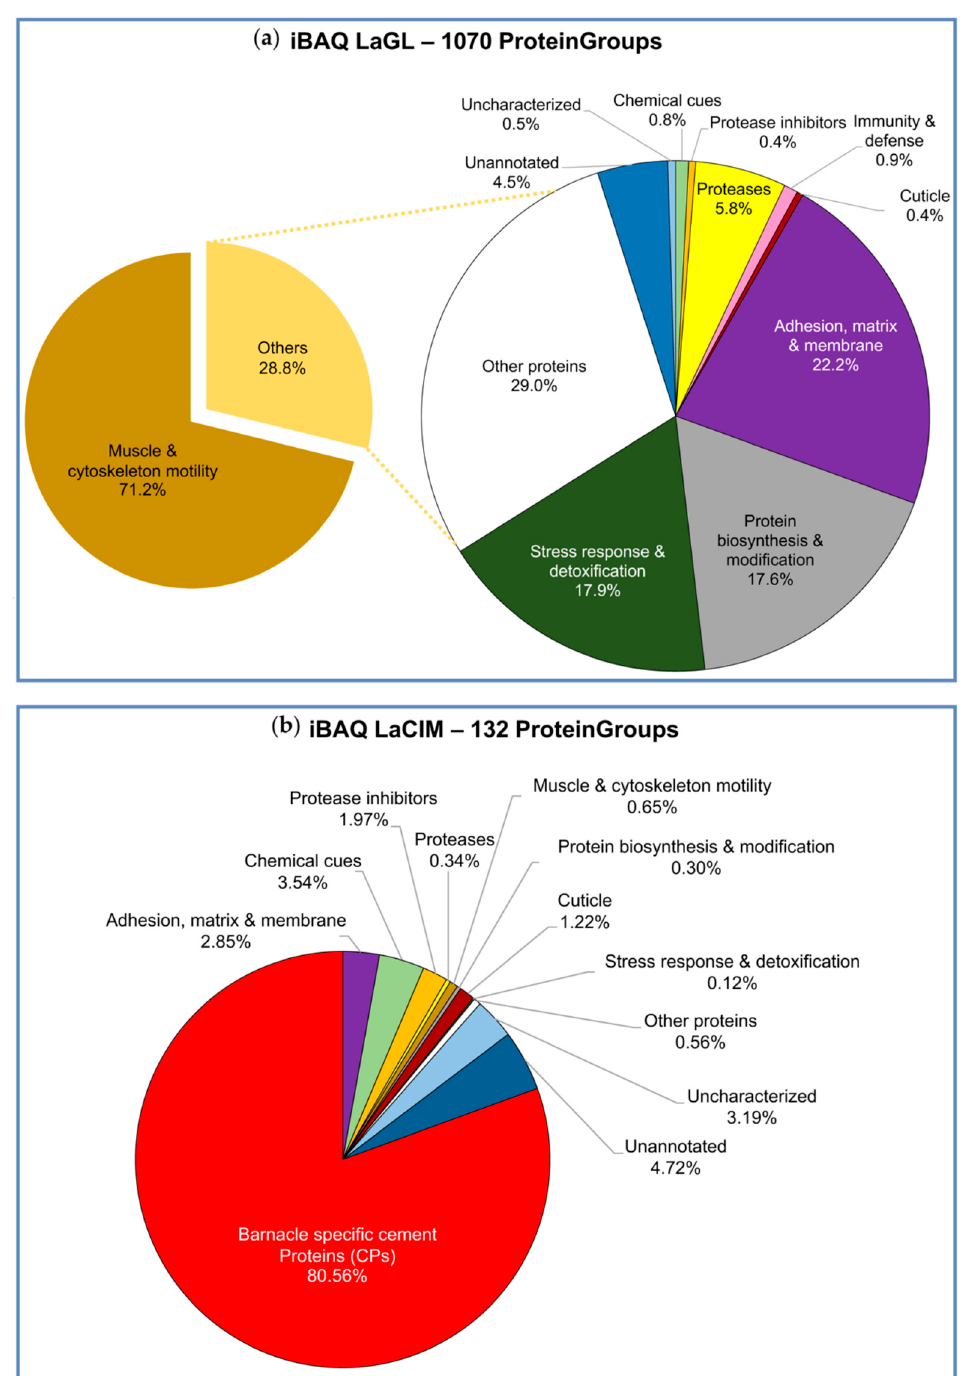
Figure 3. Global protein composition by functional groups in ( a ) the gland proteome (LaGL); and ( b ) cement proteome (LaCIM) of the goose barnacle Lepas anatifera . The proportion of functional groups was based on the absolute protein abundance using intensity Based Absolute Quantification (iBAQ) score calculated by MaxQuant. Only those proteins found in the three biological replicates (three valid values) of the two studied samples were selected. In total, 1070 proteinGroups were used in the analysis of the gland (LaGL), and 132 in the cement